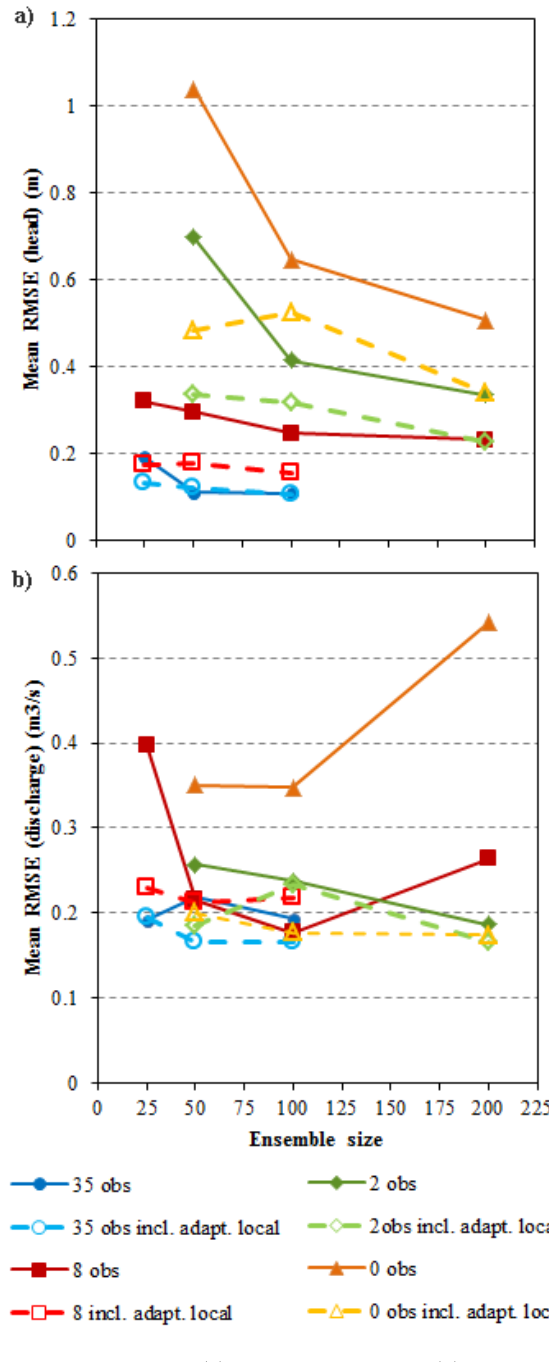
Figure 6. Head RMSE (a) and discharge RMSE (b) as a function of ensemble size in the InclParInclQ scenario for different numbers of groundwater head